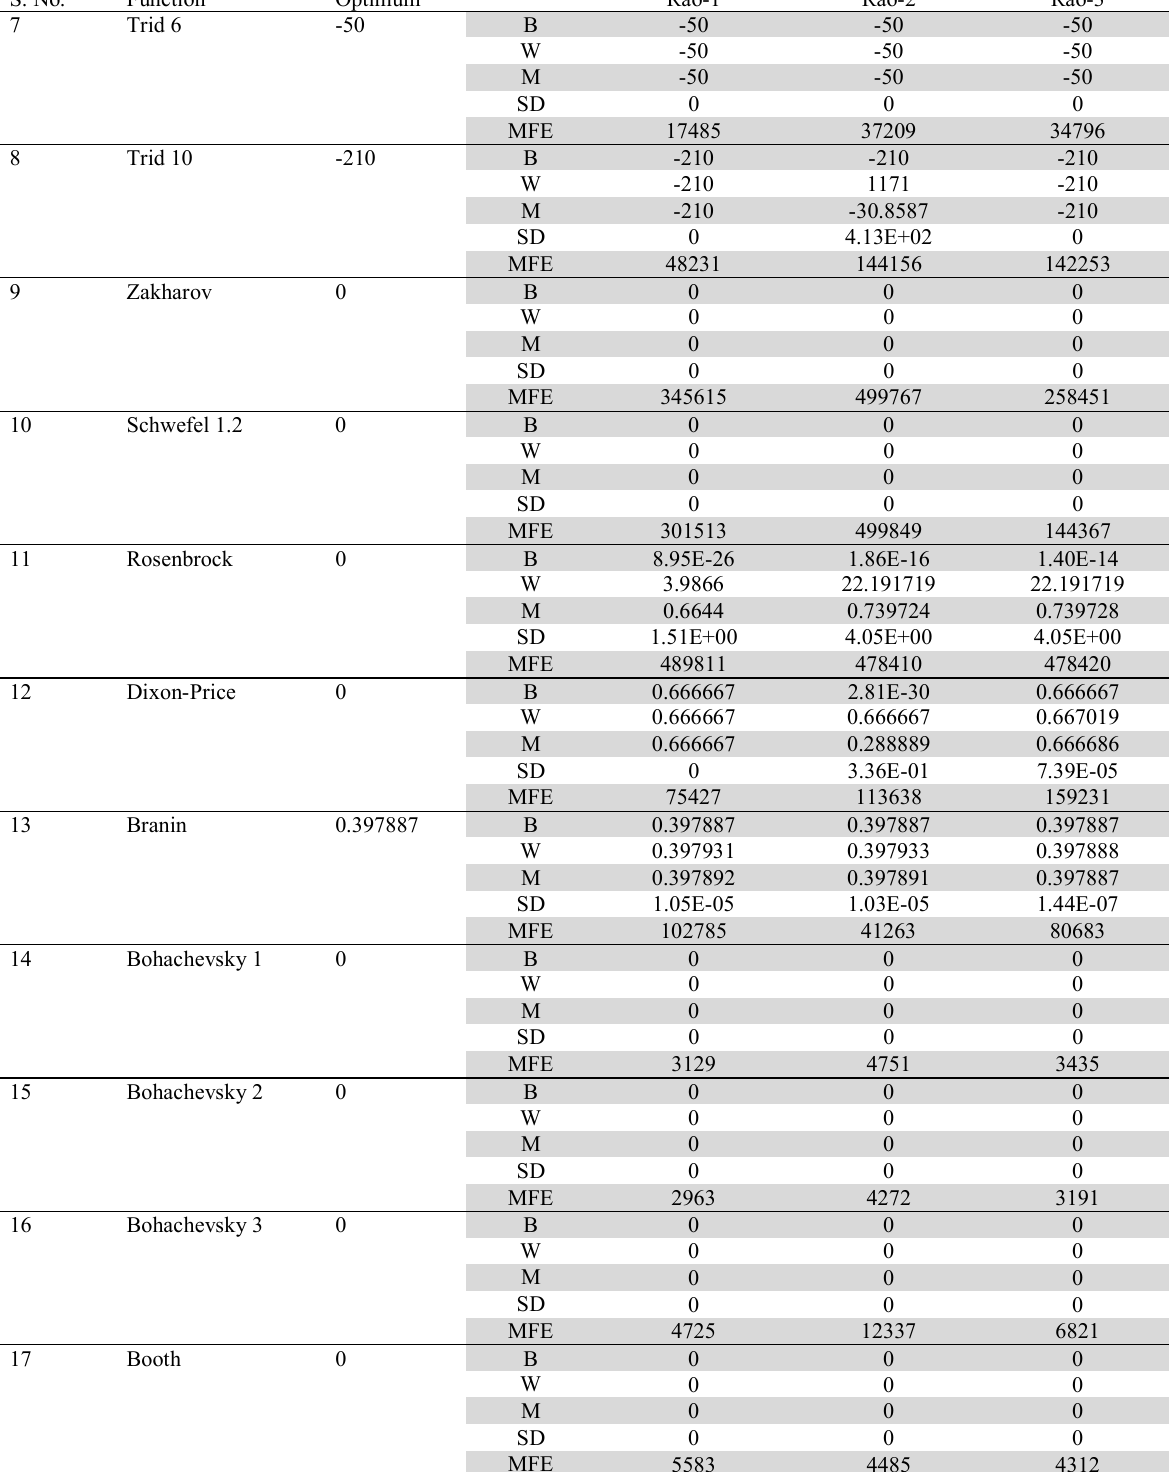
Results of the proposed algorithms for the unconstrained benchmark functions (Continued) S.